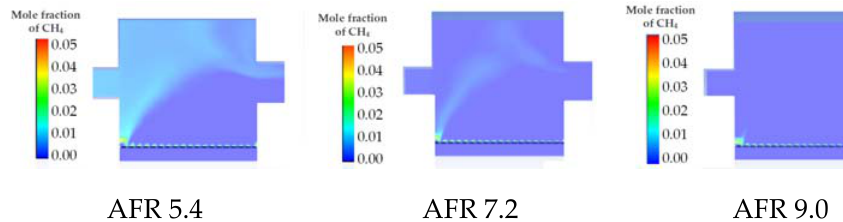
Figure 13. Contours of CO concentration.